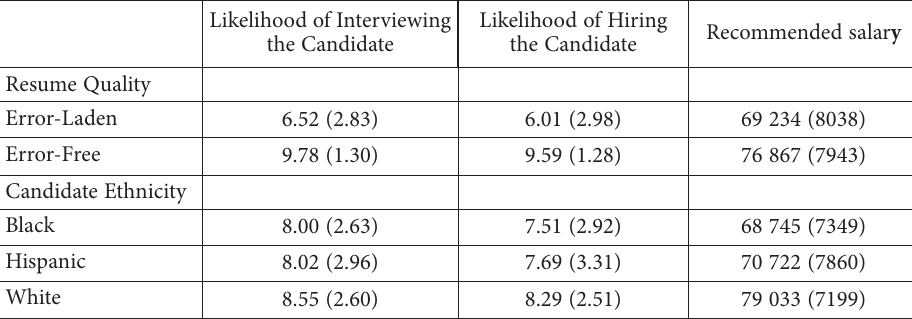
Table 1. Means and (standard deviations) of dependent variables for resume quality and candidate ethnicity conditions Likelihood of Interviewing the